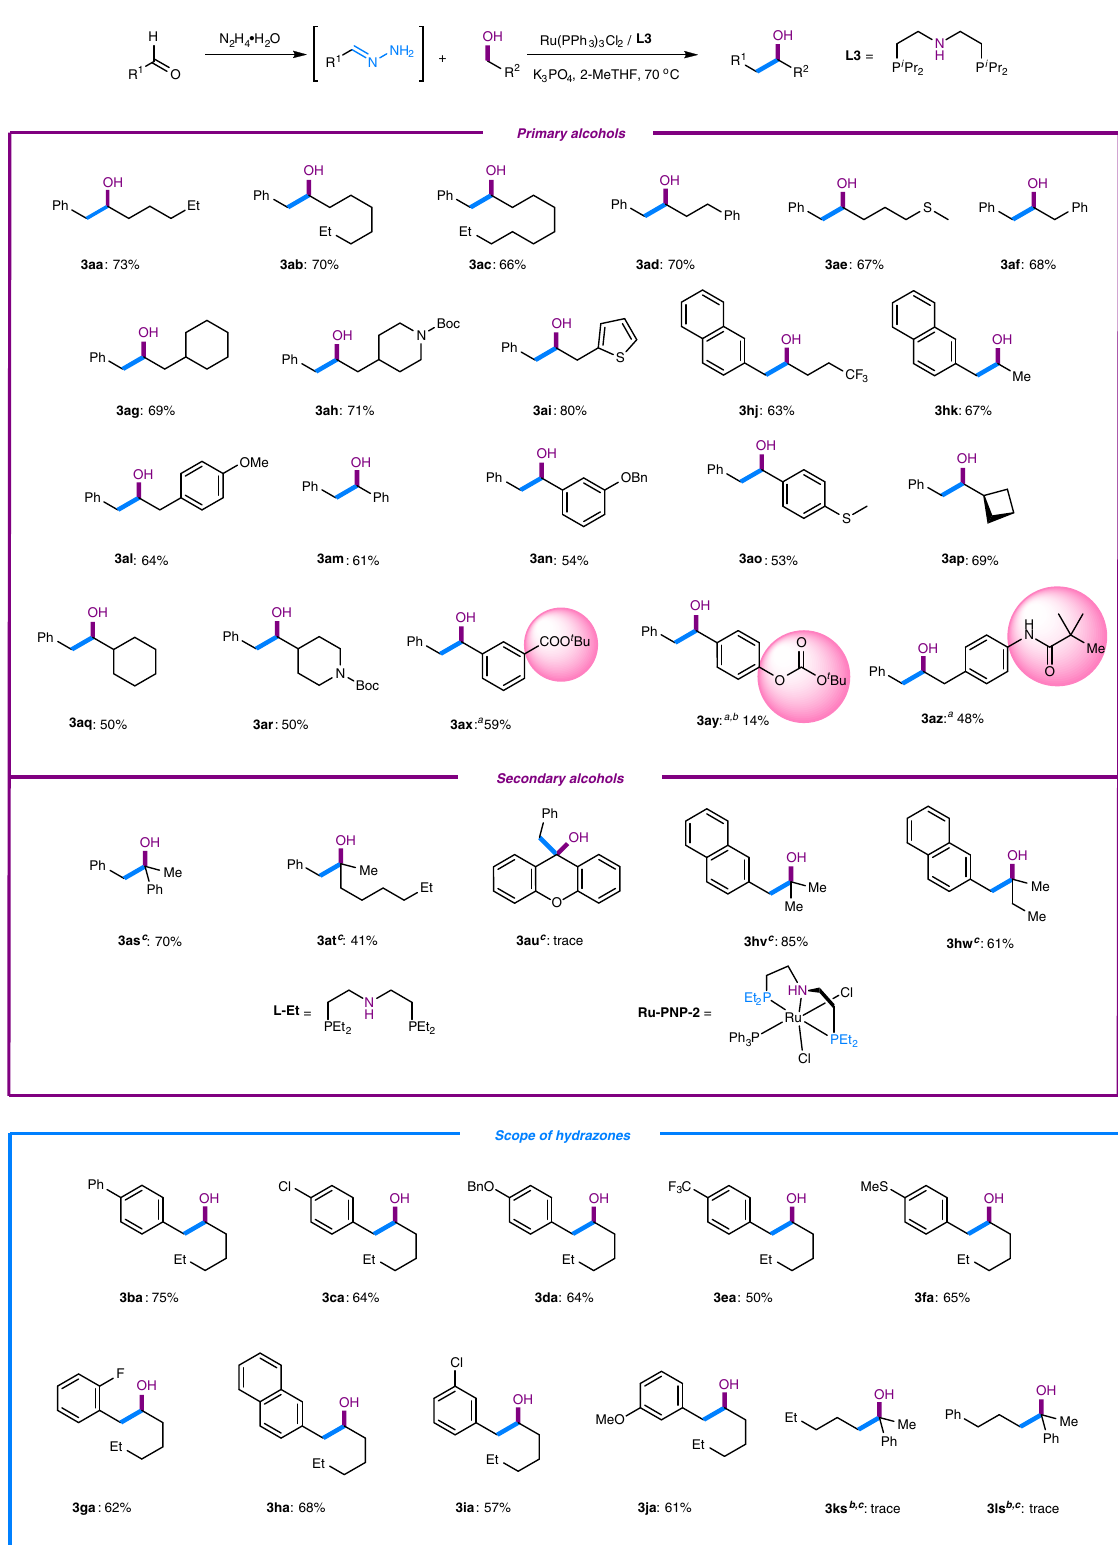
Fig. 3 Substrate scope of the alcohol-surrogated Grignard-type reaction. Reaction conditions: 1a (0.6 mmol), 2a (0.2 mmol), Ru(PPh 3 ) 3 Cl 2 (5 mol %), ligand (5 mol %) and K 3 PO 4 (2 equiv) in 2-MeTHF at 70 °C under N 2 atmosphere for 24 h. See Supplementary Information (SI) for details. Yield of isolated product was reported otherwise noted. a Ru-PNP-1 was used as catalyst. b 1 H NMR yield was determined using mesitylene as an internal standard. c The reaction was conducted at 100 °C, with 1a (0.8 mmol) and Ru-PNP-2 being the